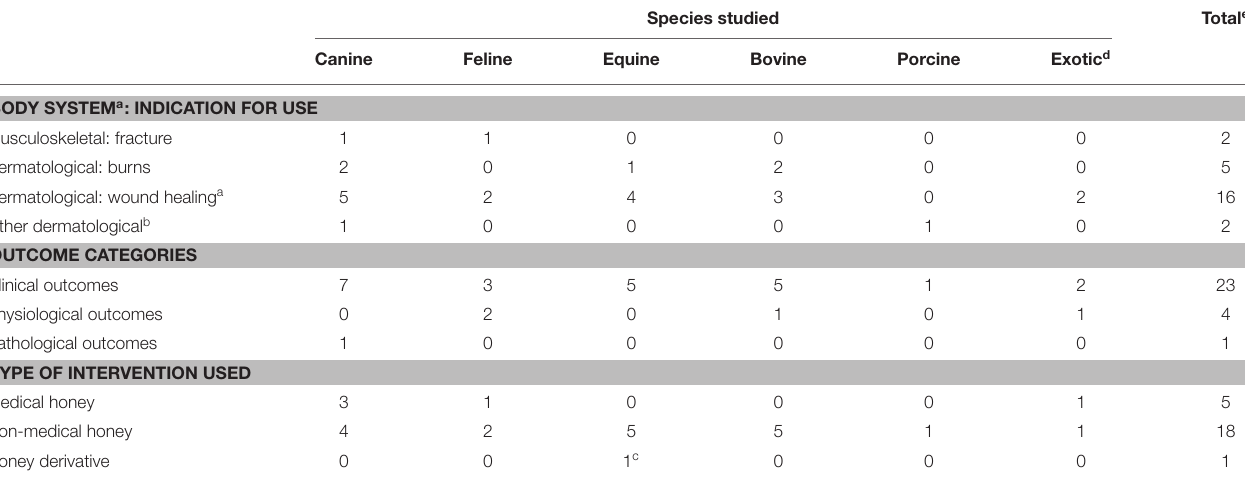
TABLE 2 | Summary of 23 veterinary case reports/series included in a scoping review of the evidence for the medicinal use of honey in animals, characterised by species, body system, indication for use, outcome category and type of honey used. Species studied Feline Equine Bovine Porcine Exotic